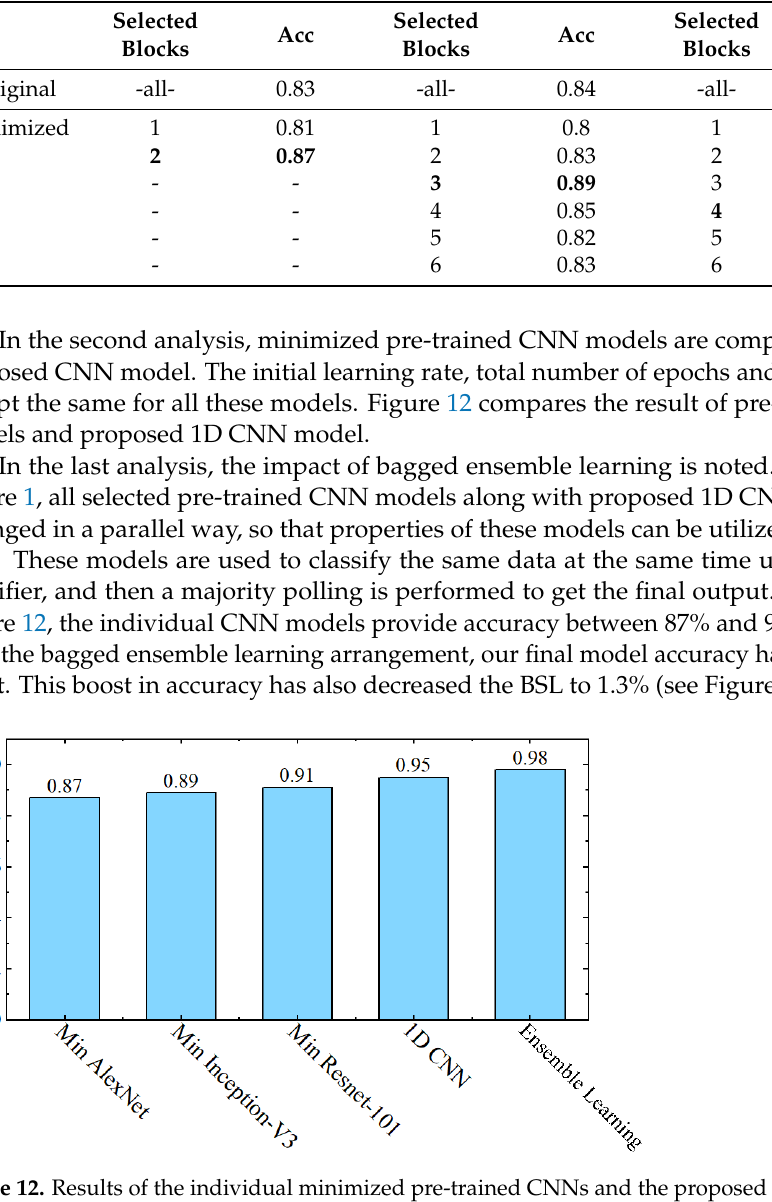
Figure 12. Results of the individual minimized pre-trained CNNs and the proposed 1D CNN model without the bagged ensemble learning arrangement, in comparison with the final model with the proposed bagged ensemble learning